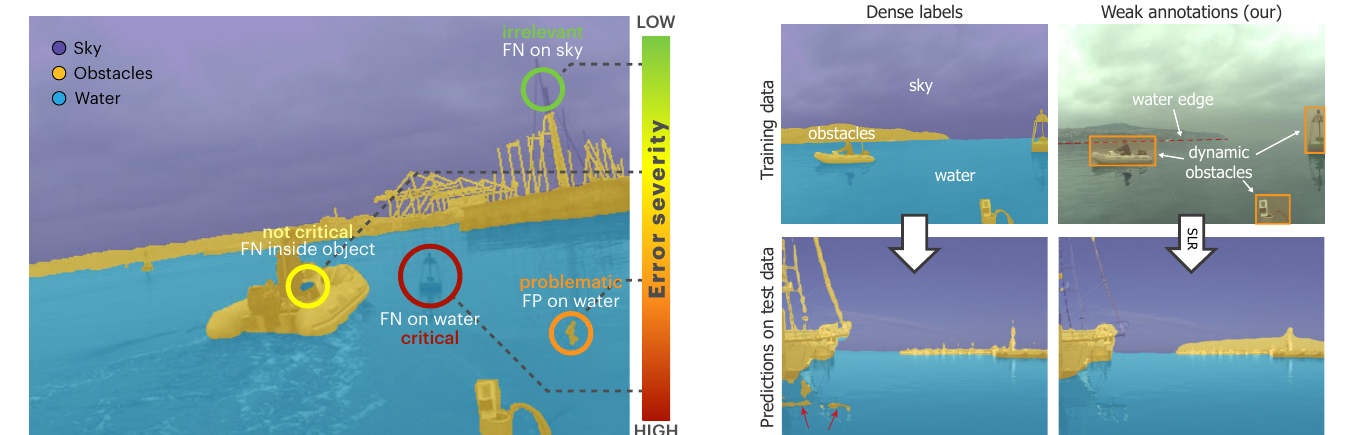
Figure 1. ( Left ) Equal-sized obstacle segmentation errors in different regions have significantly different implications for the downstream task of collision avoidance and boat navigation. ( Right ) The proposed scaffolding learning regime (SLR) trains a network with weak obstacle-oriented annotations (top right) without compromising the segmentation quality relevant to obstacle detection